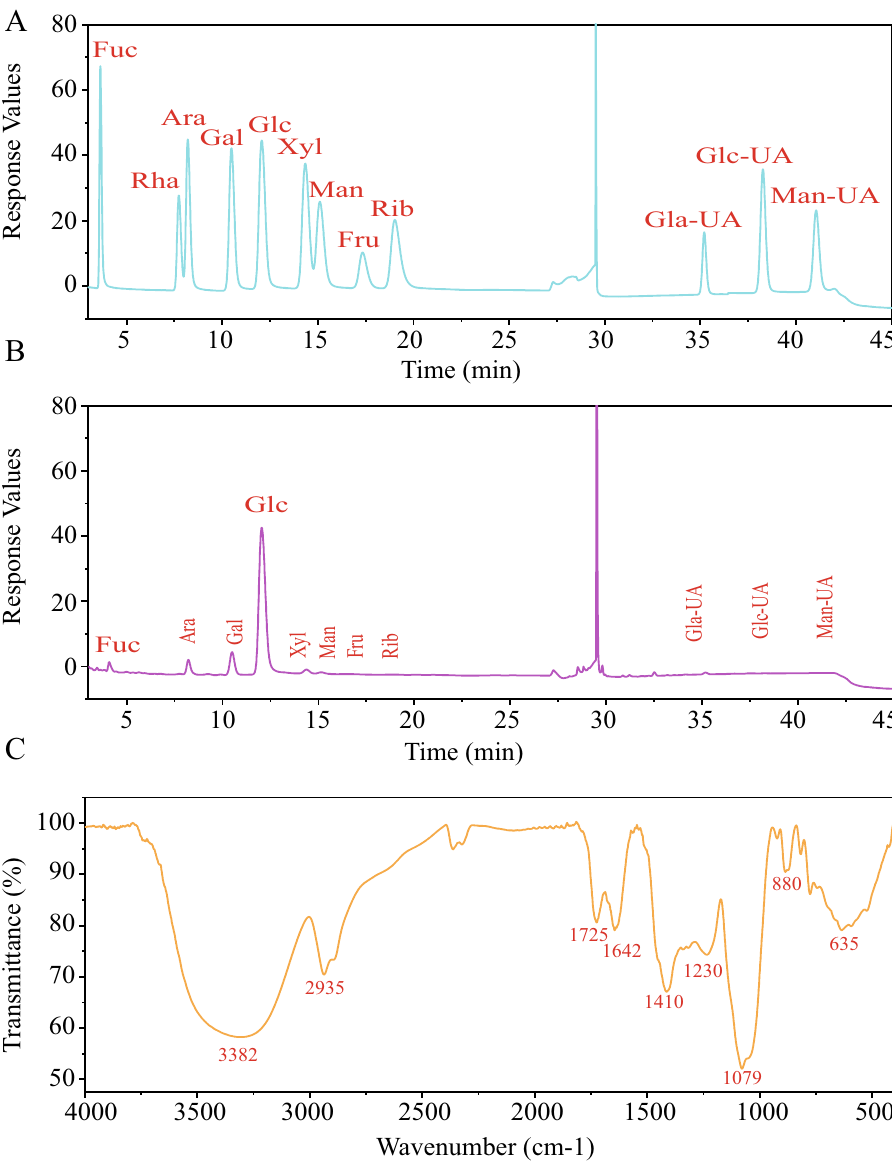
Figure 1. Analysis of the structure of AMP. ( A ) The standard monosaccharides. ( B ) The monosaccharide composition. (C) FI-IR analysis of A. melanocarpa polysaccharide. The IR spectra was analyzed on JASCO FT/ IR-620 spectrometer (http:// www. jasco. co.